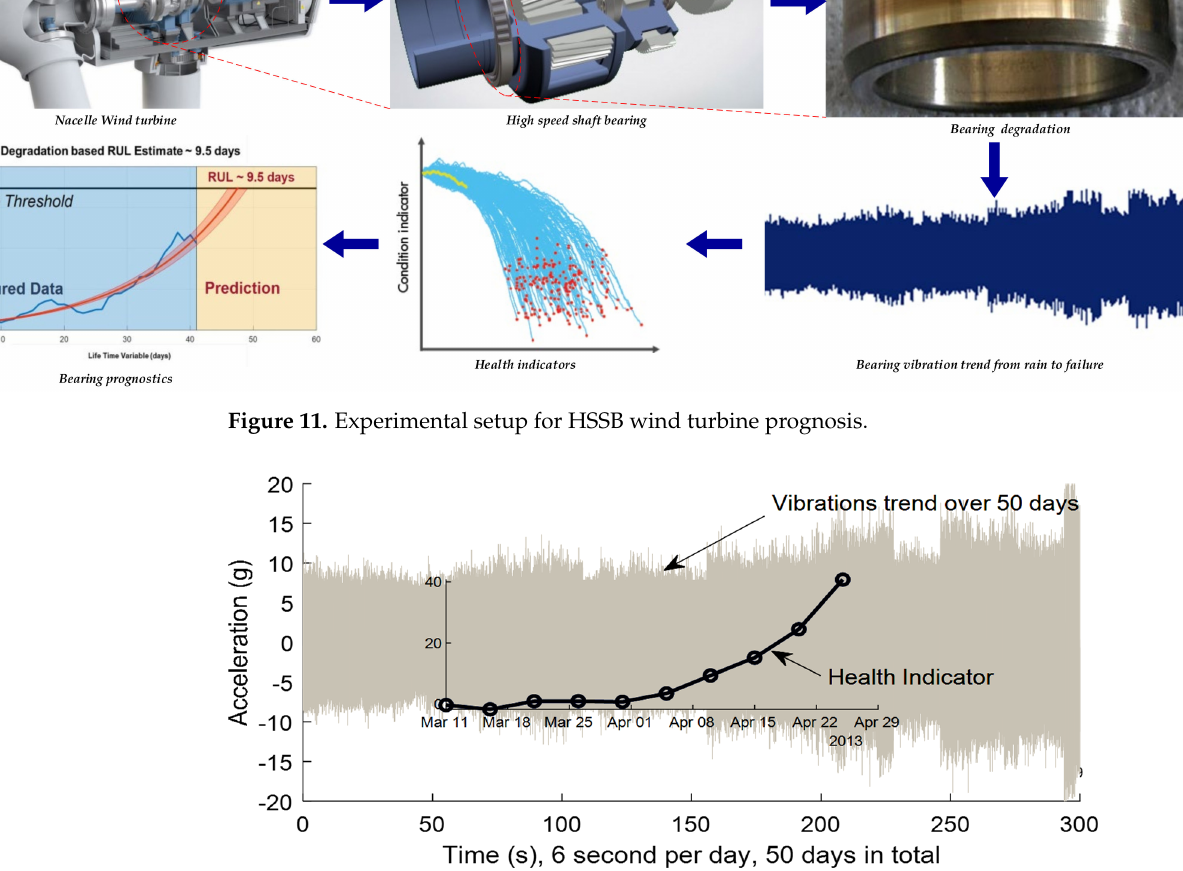
Figure 13. Bearing degradation RUL prediction results. Reproduced from [15], Elsevier. 5.2. PHM of High-Speed Shaft Bearing Wind Turbine (HSSB) Based on Physics-Based Approaches Physics-based approaches consider that a physical model describing the degradation behavior is accessible with usage conditions such as loading information. In this subsection, we introduce a prognosis method based on the hybrid approach (physical model and collected data) with confidence bounds. As we have seen previously, the severity of the degradation exponentially increases with time, and suddenly this evolution is similar to the prediction model. We give in this PHM application the Paris model (Paris and Erdogan 1963) and the smoothed Kalman filter for the RUL estimation of the HSSB described in the previous subsection, this RUL is predicted with confidence intervals. More details about the application of application the Paris model can be found in our previous paper [15]. The obtained results given in Figure 14 show that the Kalman smoother is an effective way to improve trending and RUL estimation. -20